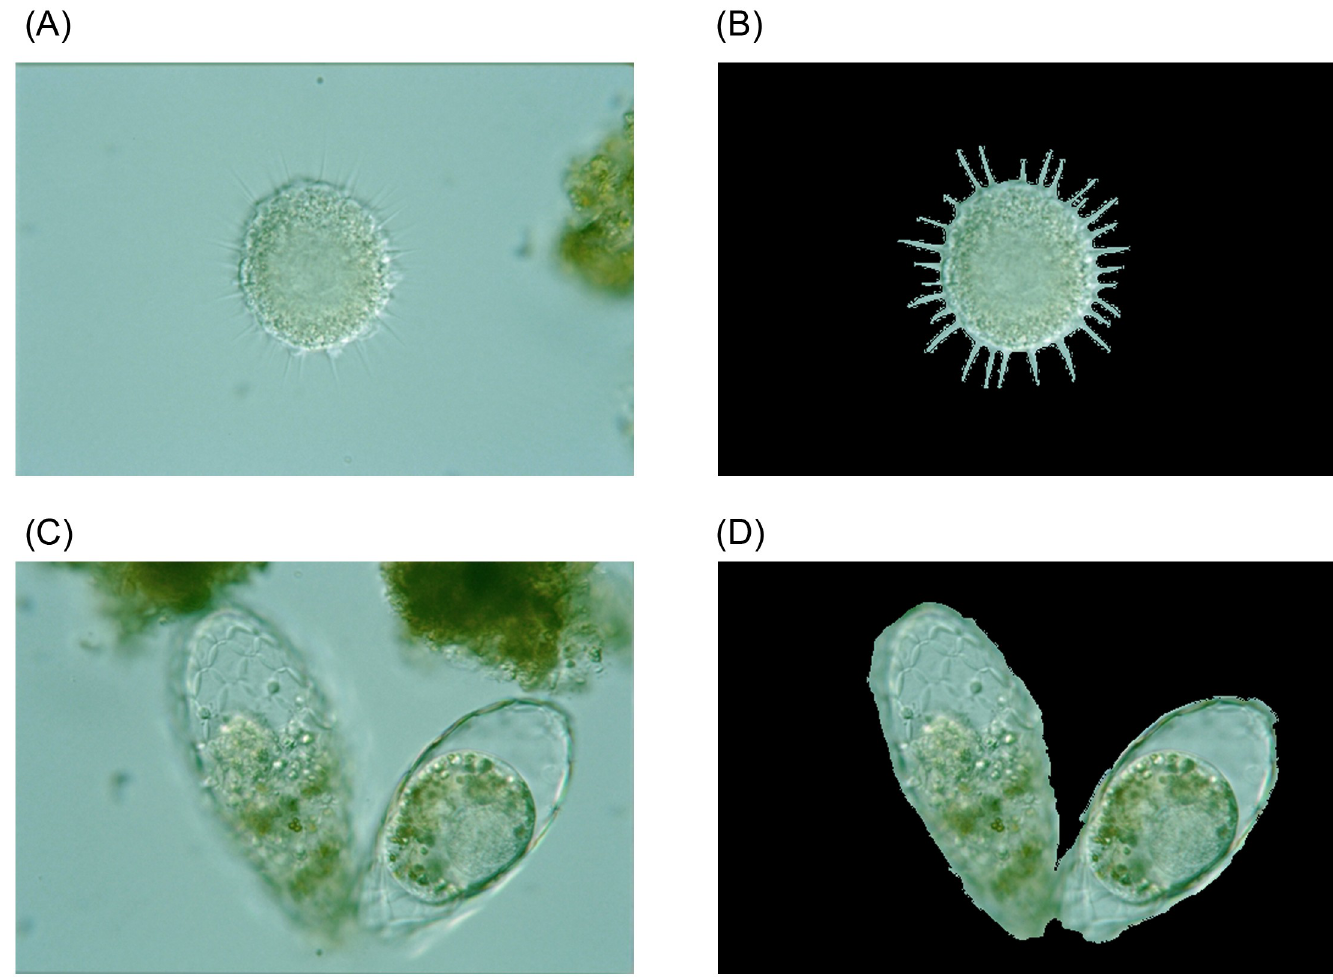
Fig 8. An example of localized EMs by GT